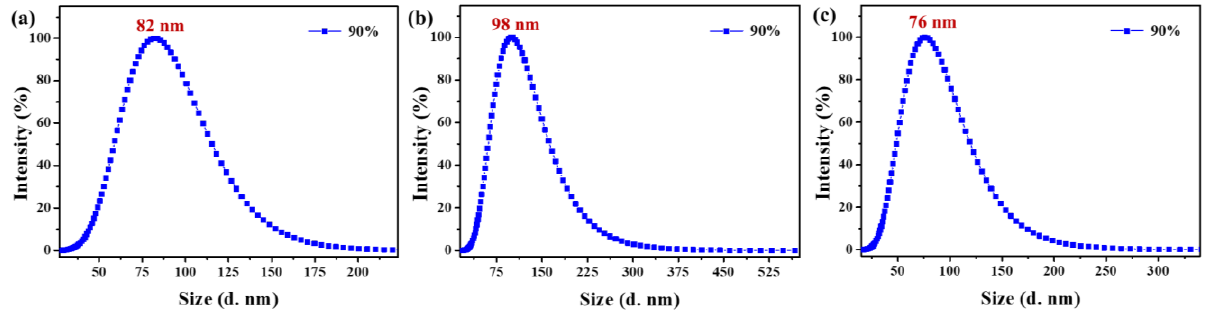
Figure 2. Size distribution curves of 1 – 3 ( a – c ) in DMF-H 2 O mixtures with f w = 90%. Concentration: 20